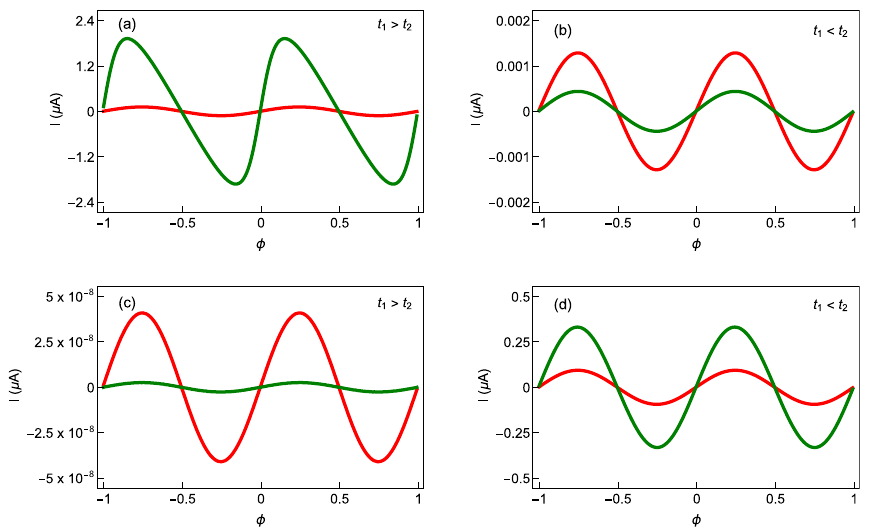
Figure 5. Current-flux characteristics for the AAH SSH rings in the half-filled band case at two different AAH modulation strengths, where the red and green curves correspond to W = 1 and 1.25 eV, respectively. The first row represents the non-staggered [( a ) t 1 > t 2 and ( b ) t 1 < t 2 ] case while the second row represents the staggered one [( c ) t 1 > t 2 and ( d ) t 1 < t 2 ]. Here we choose N = 20 , and all other parameters are the same as given